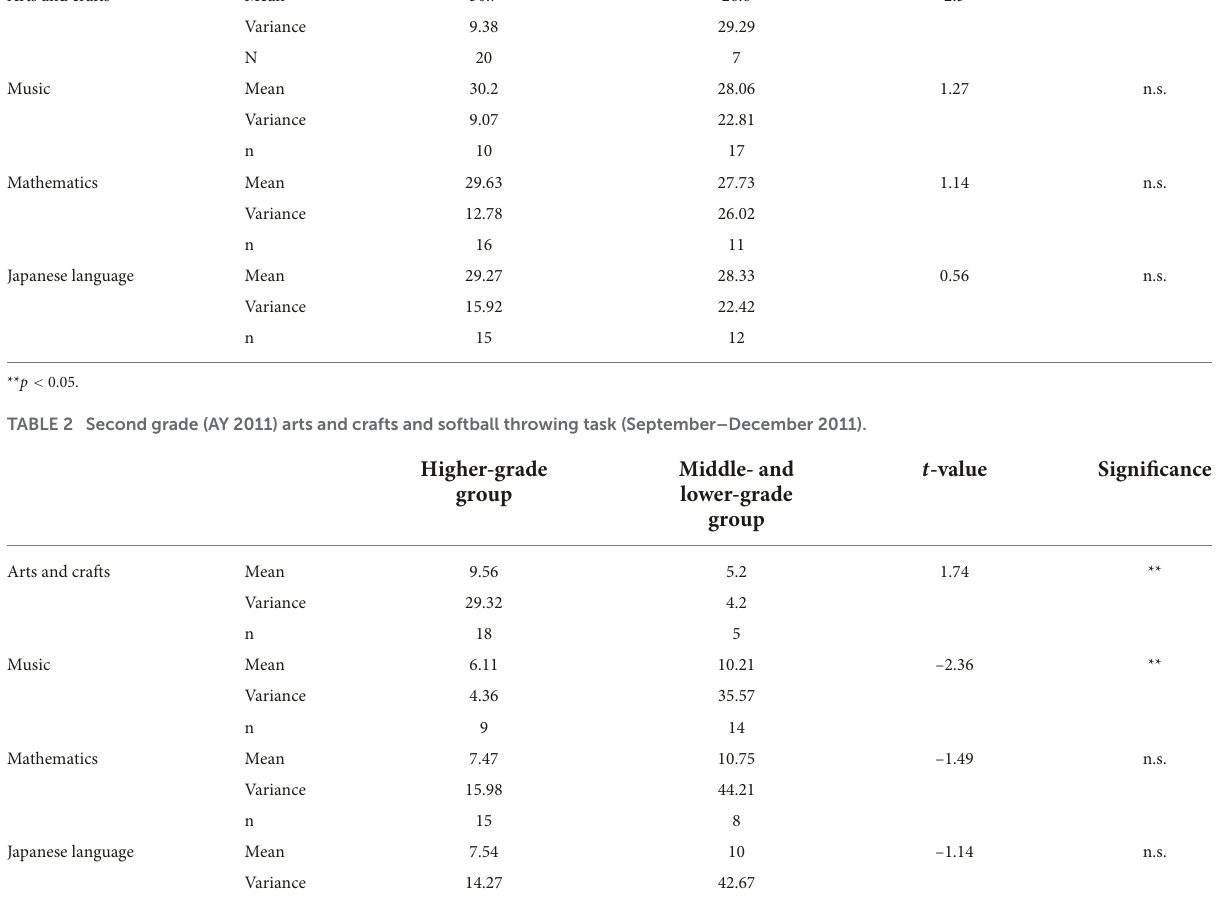
t -value Higher-grade Middle- and group lower-grade group